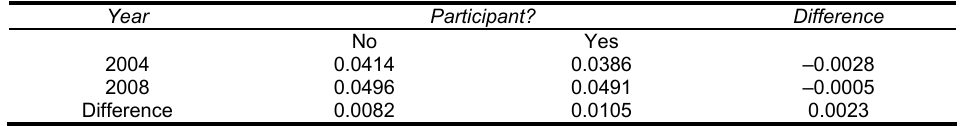
Table 1: Average re-employment rates at the PES offices by HRDOP 1.2 programme participation status and